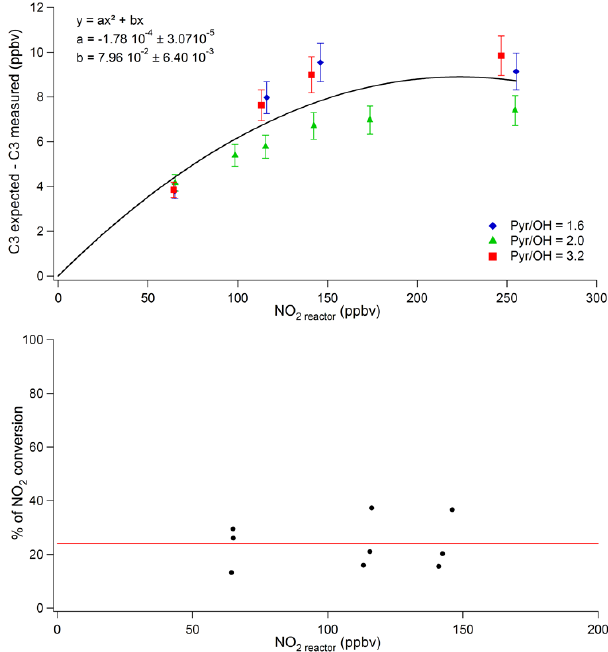
Figure 4. Experimental parameterization of the NO 2 artifact. Top panel: changes in C3 ( (cid:49) C3 = C3 expected − C3 measured) as a function of NO 2 in the CRM reactor. Three experiments conducted at pyrrole-to-OH ratios of 1.6 (blue diamonds), 2.0 (green trian- gles), and 3.2 (red squares) are shown. Error bars are uncertainties in (cid:49) C3 (approximately 9%) calculated by a quadratic propagation of errors. The black line and the equation correspond to a quadratic regression for the three experiments. Bottom panel: quantification of the NO 2 fraction converted into NO (see text). The red line is the mean value of approximately 24% derived for the NO 2